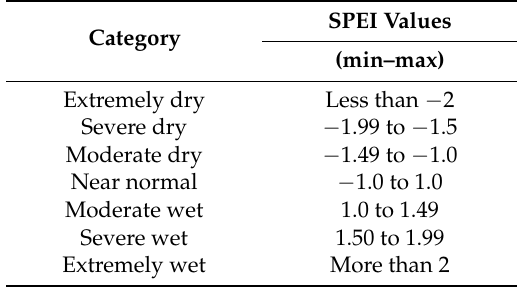
Table 1. Categories of dry/wet classes by the SPEI following McKee et al.